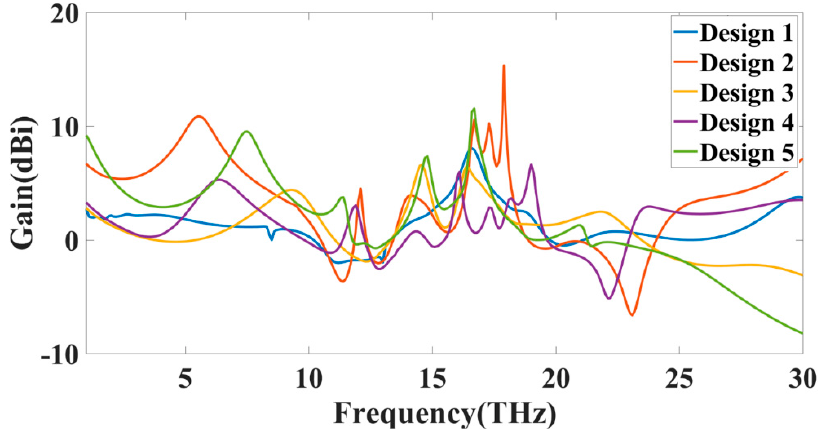
Figure 13. Calculated (simulated results) variation in gain (dBi) for all the antenna structures.